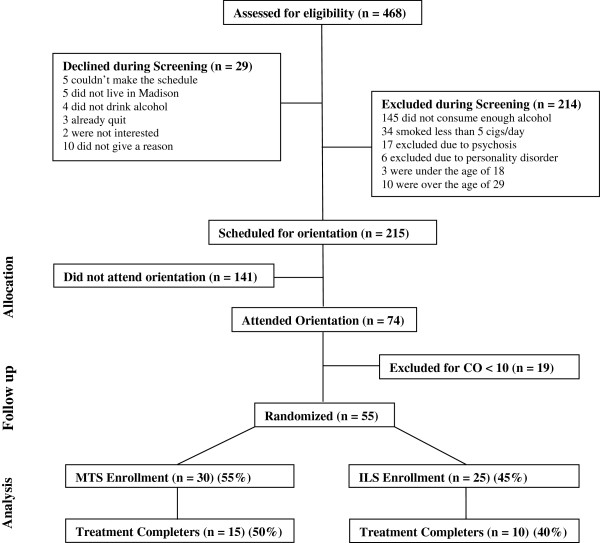
Consort diagram.